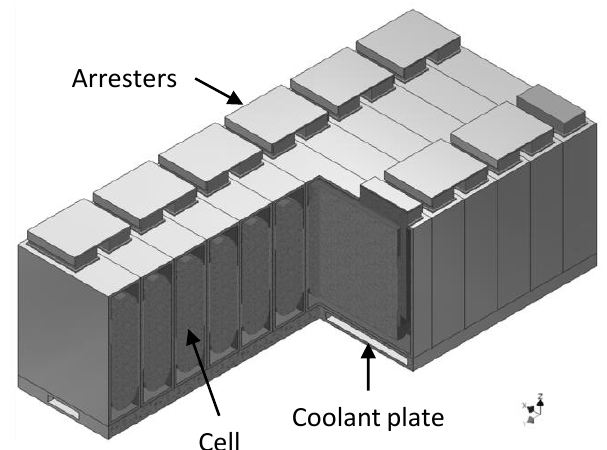
Figure 4. Overview of the battery module geometry. Shown are 12 prismatic cells covered in hard cases, arresters, and the coolant plate (modified from Angermeier et al. [24]).